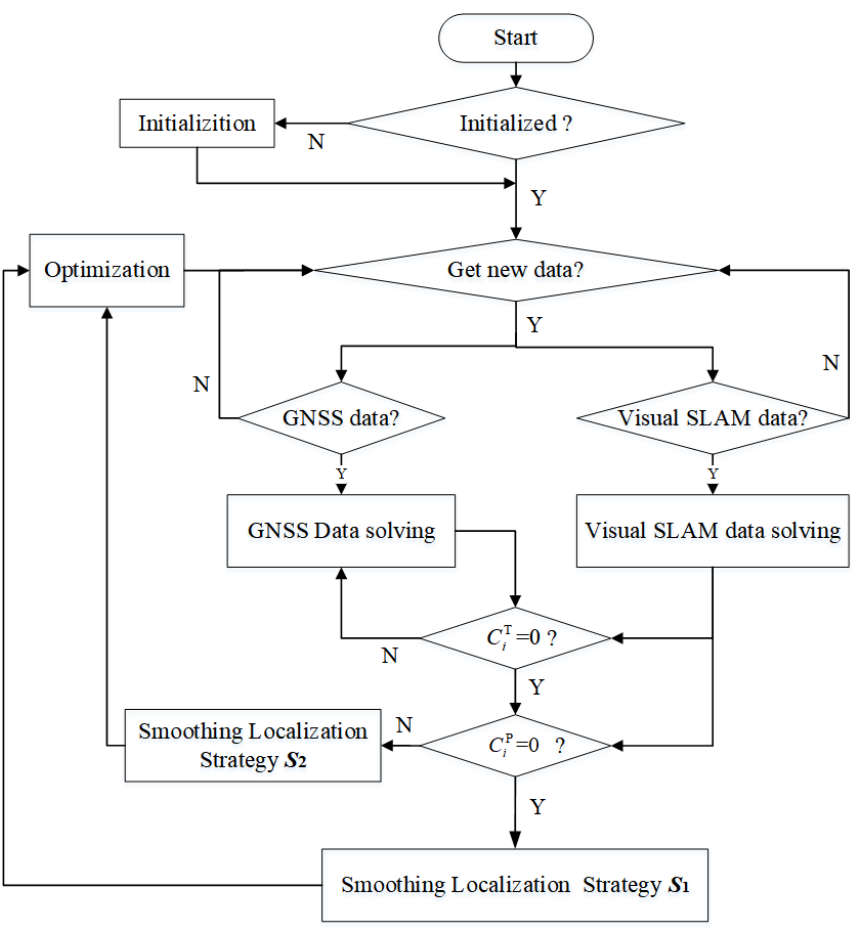
Figure 4. Figure 4. Flow-chart.